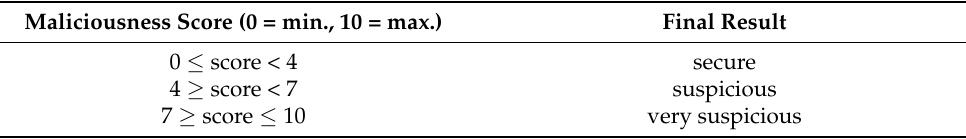
Table 14. The final score of URL